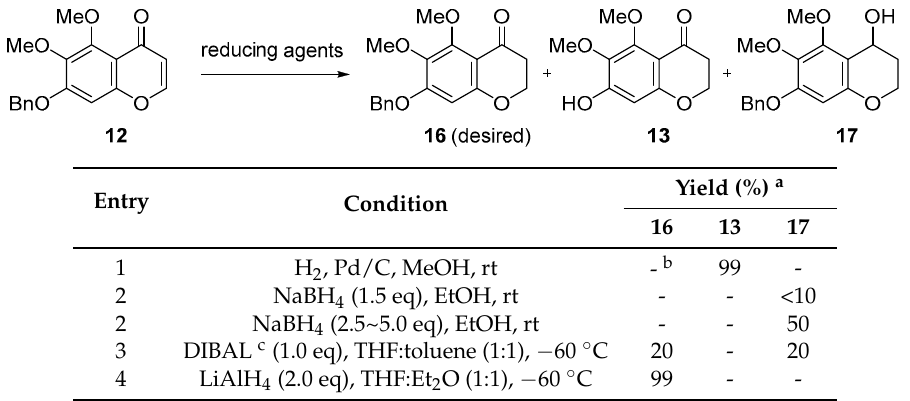
Molecules 2016 , 21 , 1058 Table 1. Reduction conditions of 7-benzyloxy-5,6-dimethoxy-4-chromenone ( 12 ).